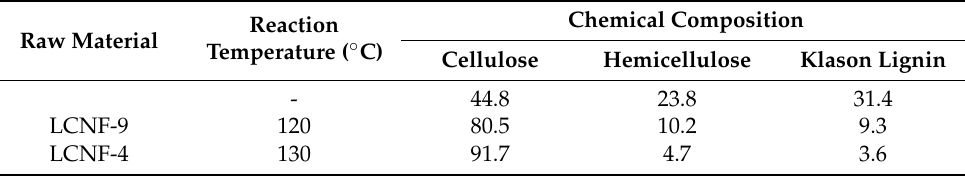
Table 1. Chemical composition of LCNFs prepared by ChCl-LA DES pretreatment. Raw